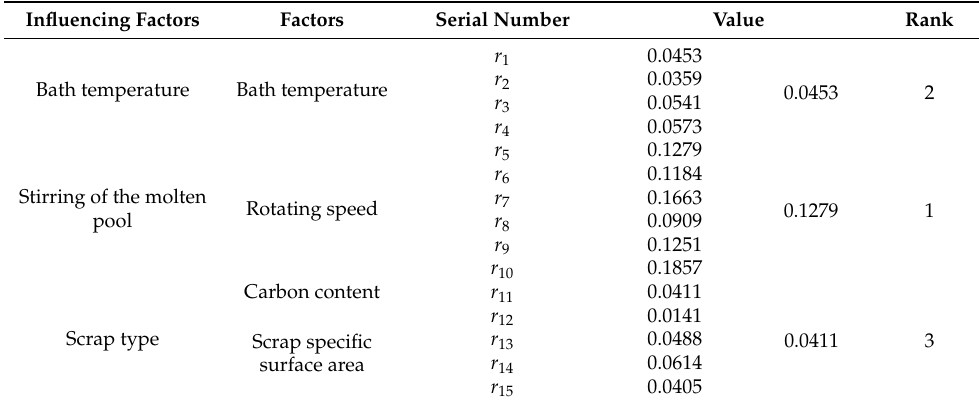
Table 4. Comprehensive evaluation